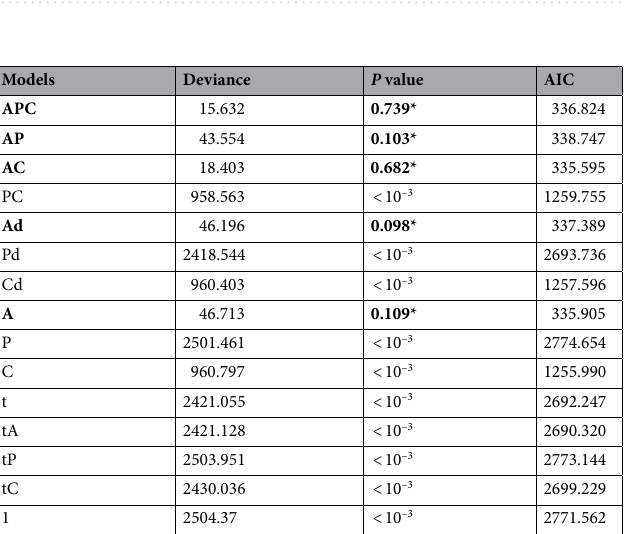
Figure 4. Time series of annual average incidence variation in multiple sclerosis per 100,000 population next age by birth cohort, all sexes combined ( a ), for men ( b ) and for women ( c ).